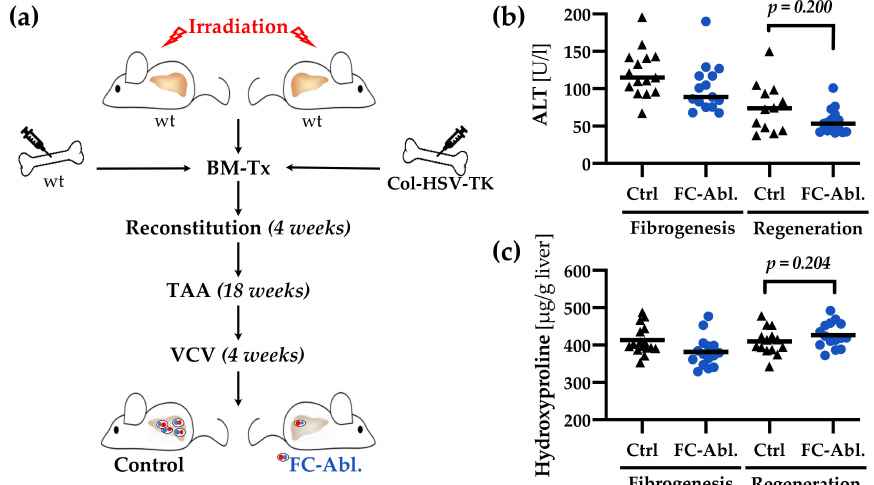
Figure 6. A four-week period was not su ffi cient to provoke regression of fibrosis. ( a ) Schematic representation of the animal experiments. Fibrocytes were depleted in mice of the respective group via the administration of VCV during a four-week regeneration period. ( b ) The direct comparison of serum ALT levels of mice sacrificed during fibrogenesis (see Section 3.5) and after regeneration shows an ameliorated disease state four weeks after the last TAA-administration. FC depletion during regeneration did not alter ALT levels. Median is depicted, Mann-Whitney U test was applied. ( c ) The direct comparison of hepatic hydroxyproline content indicates that a resolution of fibrosis cannot be observed after a regeneration period as short as four weeks. FC depletion during regeneration did not influence hydroxyproline levels. Mean is depicted, an unpaired t -test (two-tailed) was